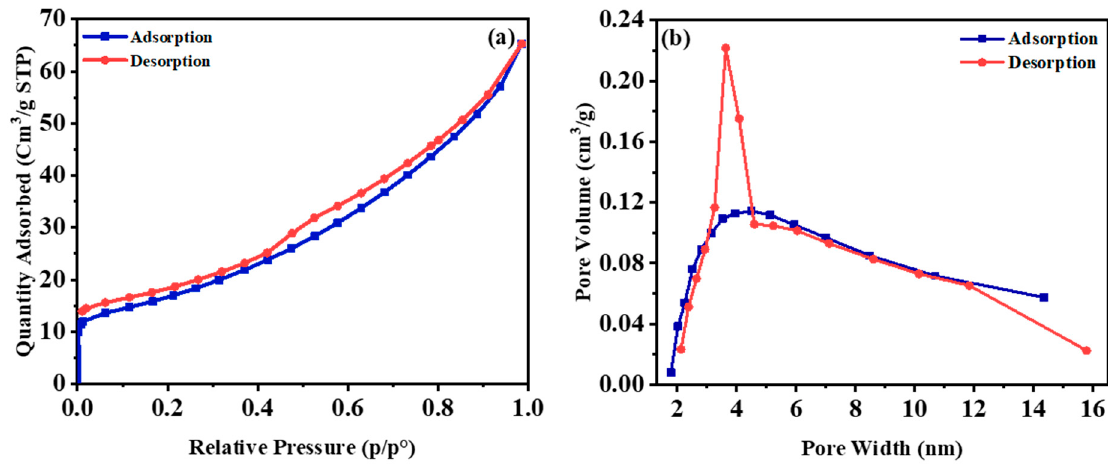
Figure 8. ( a ) Nitrogen adsorption–desorption isotherms of SiC nanoparticles, and ( b ) Pore size distribution (BJH) of SiC nanoparticles obtained at 1500 °C for 2 h.